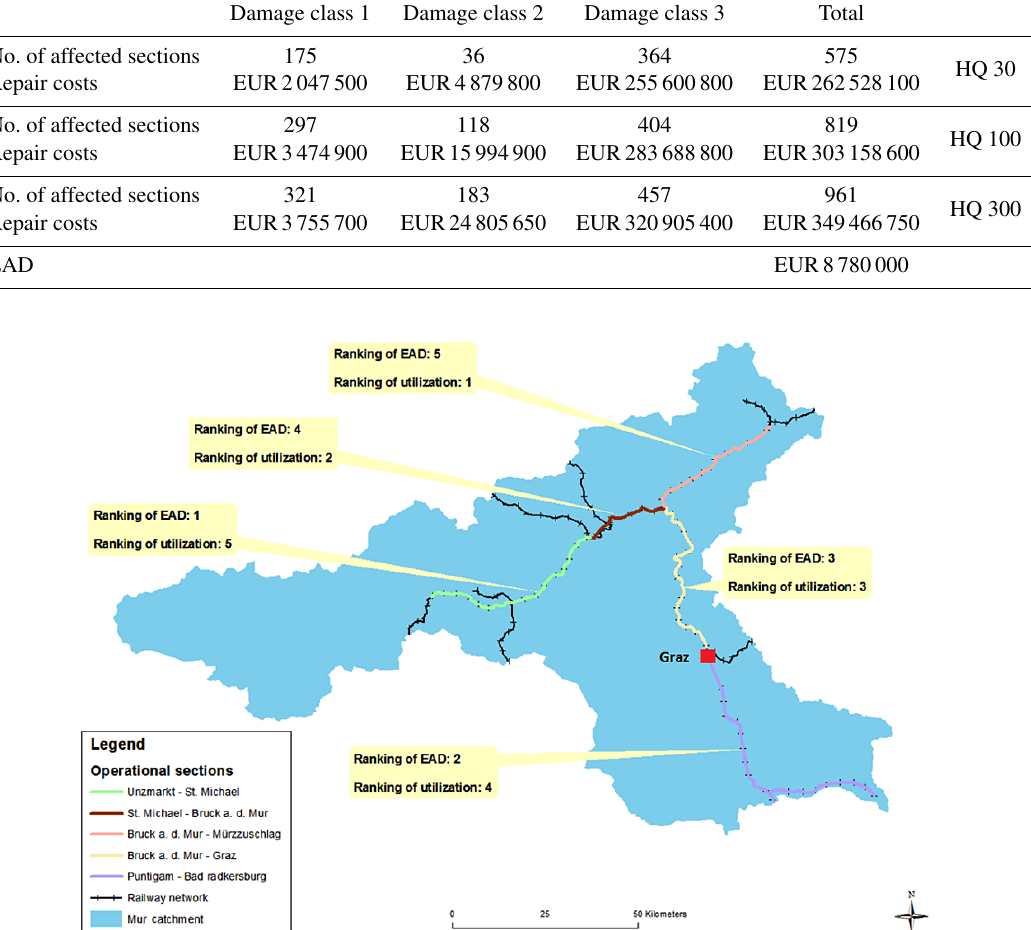
Table 1. Estimated number of damaged track sections per damage class and per flood scenario as well as related repair costs on the Mur catchment level. The EAD is rounded to three significant digits.